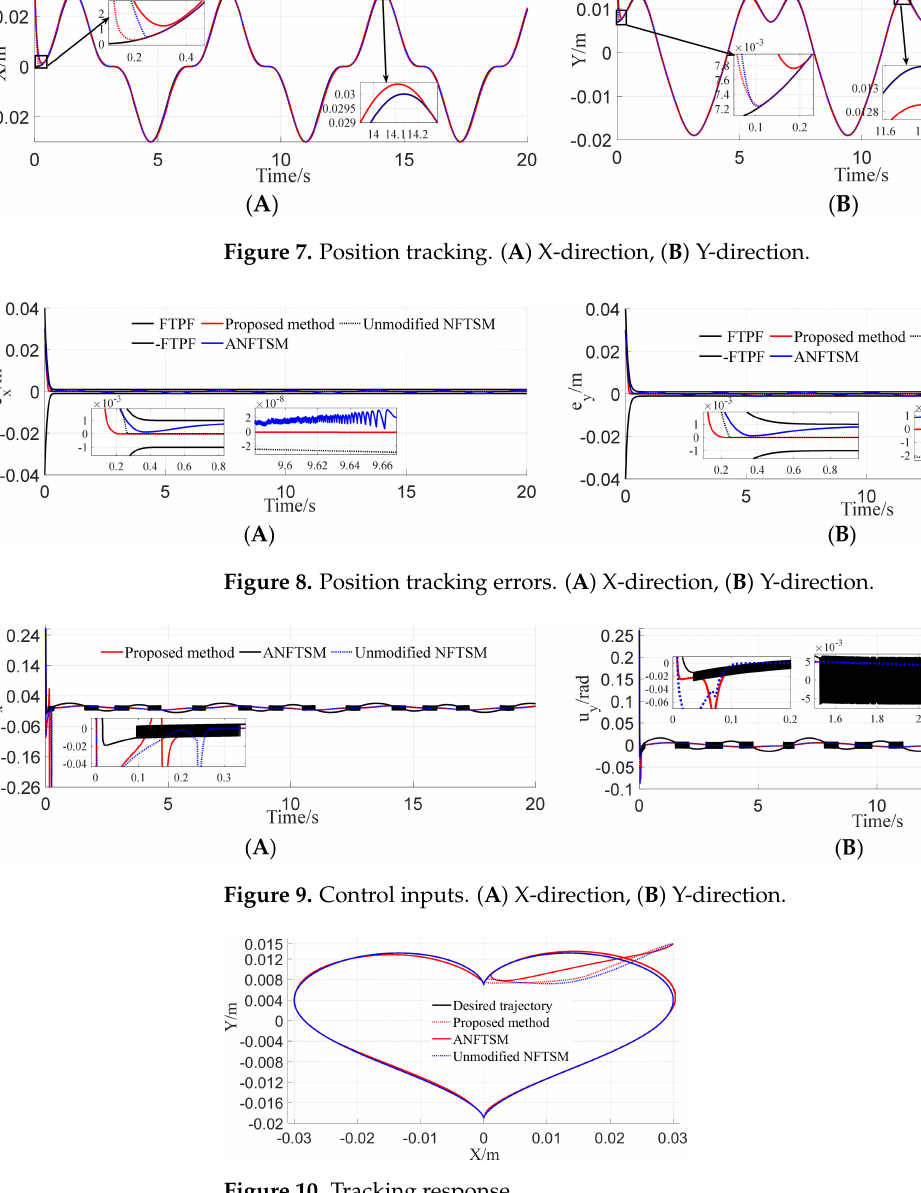
Figure 10. Tracking response.